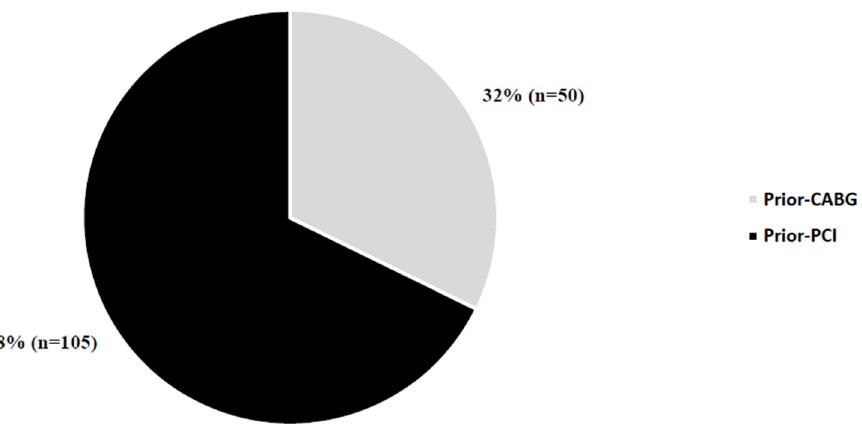
Figure 1. Number of patients in study groups. Abbreviations: CABG, coronary artery bypass grafting; PCI, percutaneous coronary intervention.